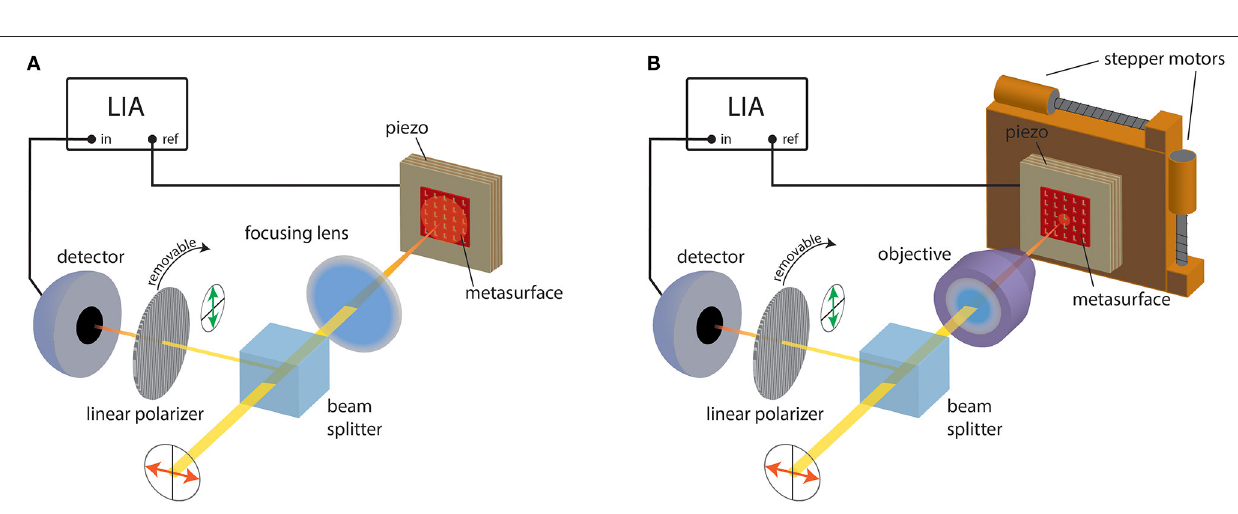
FIGURE 3 | Experimental set configurations. (A) Sketch of the experimental setup. The laser light is focused on the metasurface; the reflected signal is then sent to an IR detector through a beam splitter. A linear polarizer filter can be inserted before detection. The signal is then analyzed with a lock-in amplifier (LIA) whose reference signal is used to control the piezoelectric driving stack. (B) Same as (A) with a microscope objective instead of the focusing lens and the metasurface additionally sitting on a motorized stage for spatial maps. Note that in the sketches the laser beam size is not in